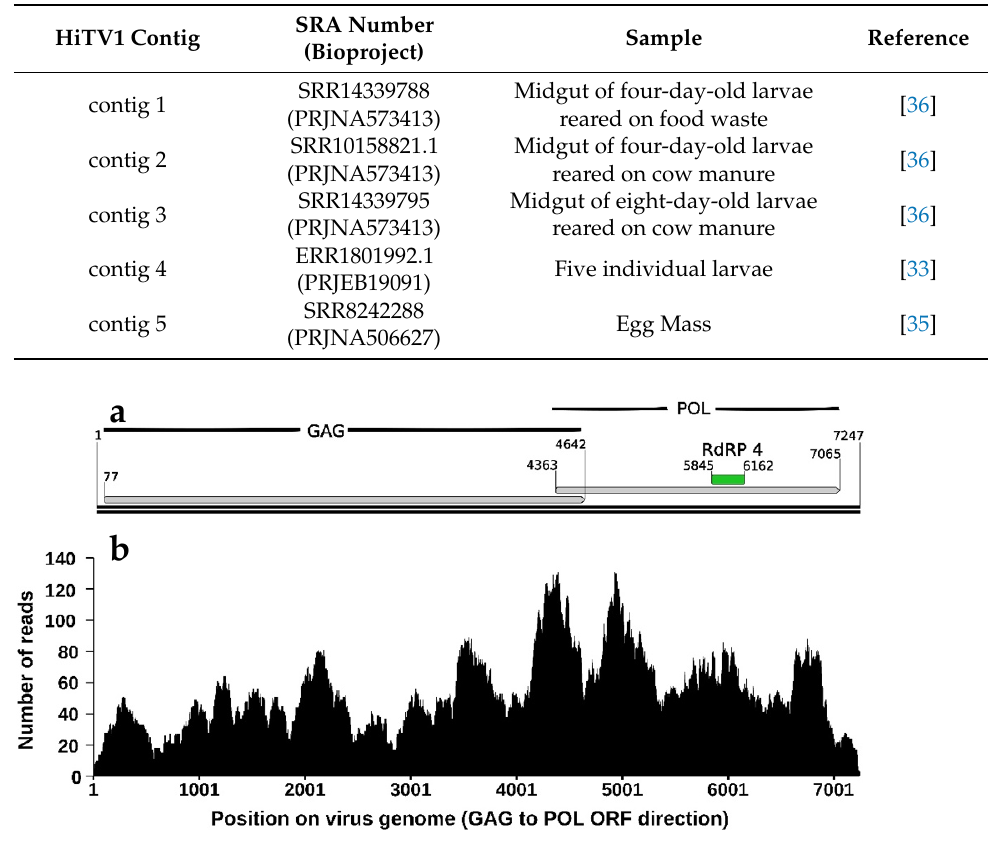
Figure 2. Annotation of HiTV1 genome sequence ( a ) and read coverage ( b ). ( a ) Numbers represent the nucleotide position, and two long horizontal black lines represent the double-stranded RNA sequence. A conserved RdRP 4-like domain (E-value of 1.46 × 10 − 4 , PF02123) was annotated in green. ( b ) Using Bowtie2 [60] and SAMtools [61], raw sequence reads from the transcriptome SRR14339788 were mapped onto the HiTV1 contig 1, which resulted from a SPAdes assembly of SRR14339788 reads. The average coverage of the reads across the contig without gaps was